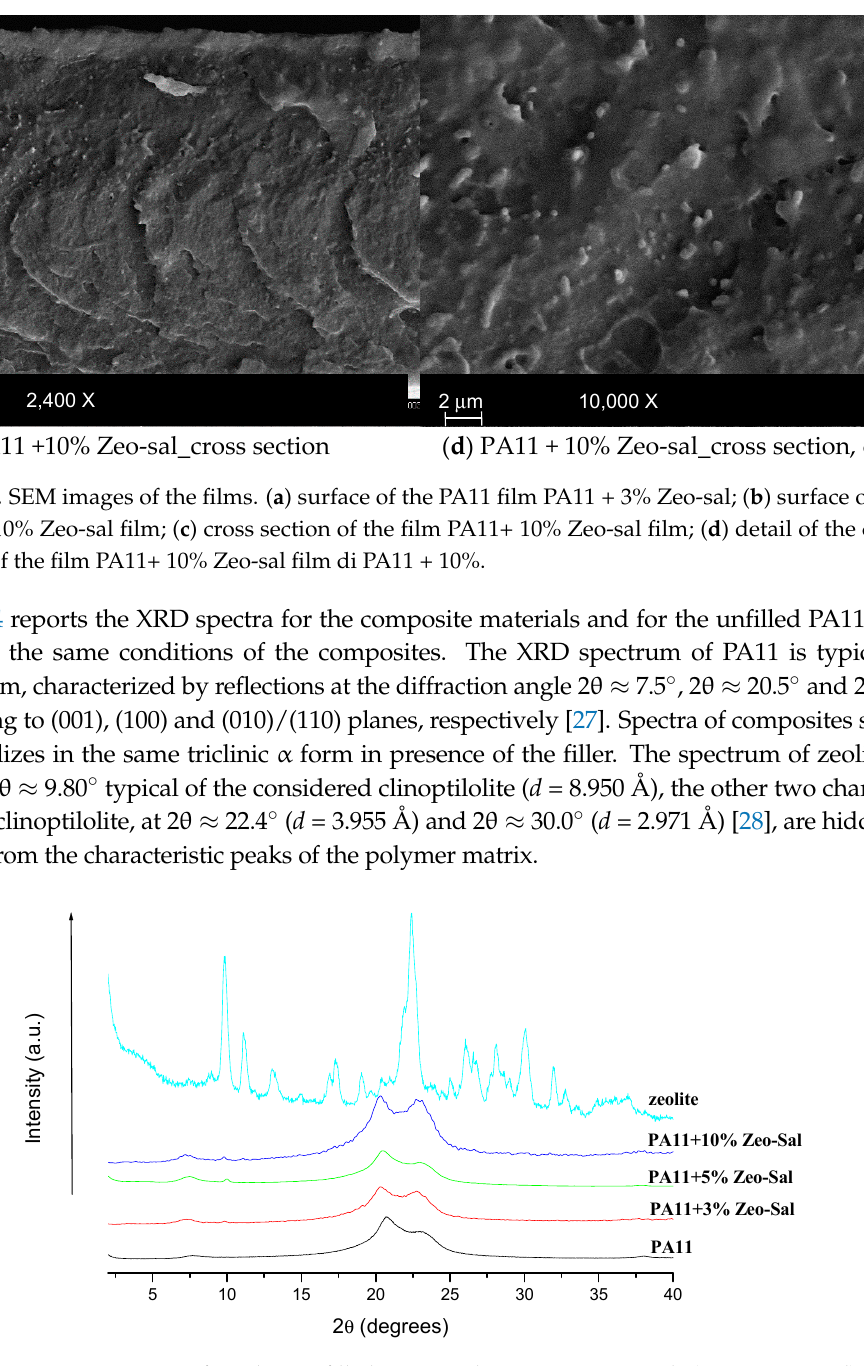
Figure 4. XRD spectra of: zeolite, unfilled PA11, and composite materials (PA11 + Zeo-Sal).